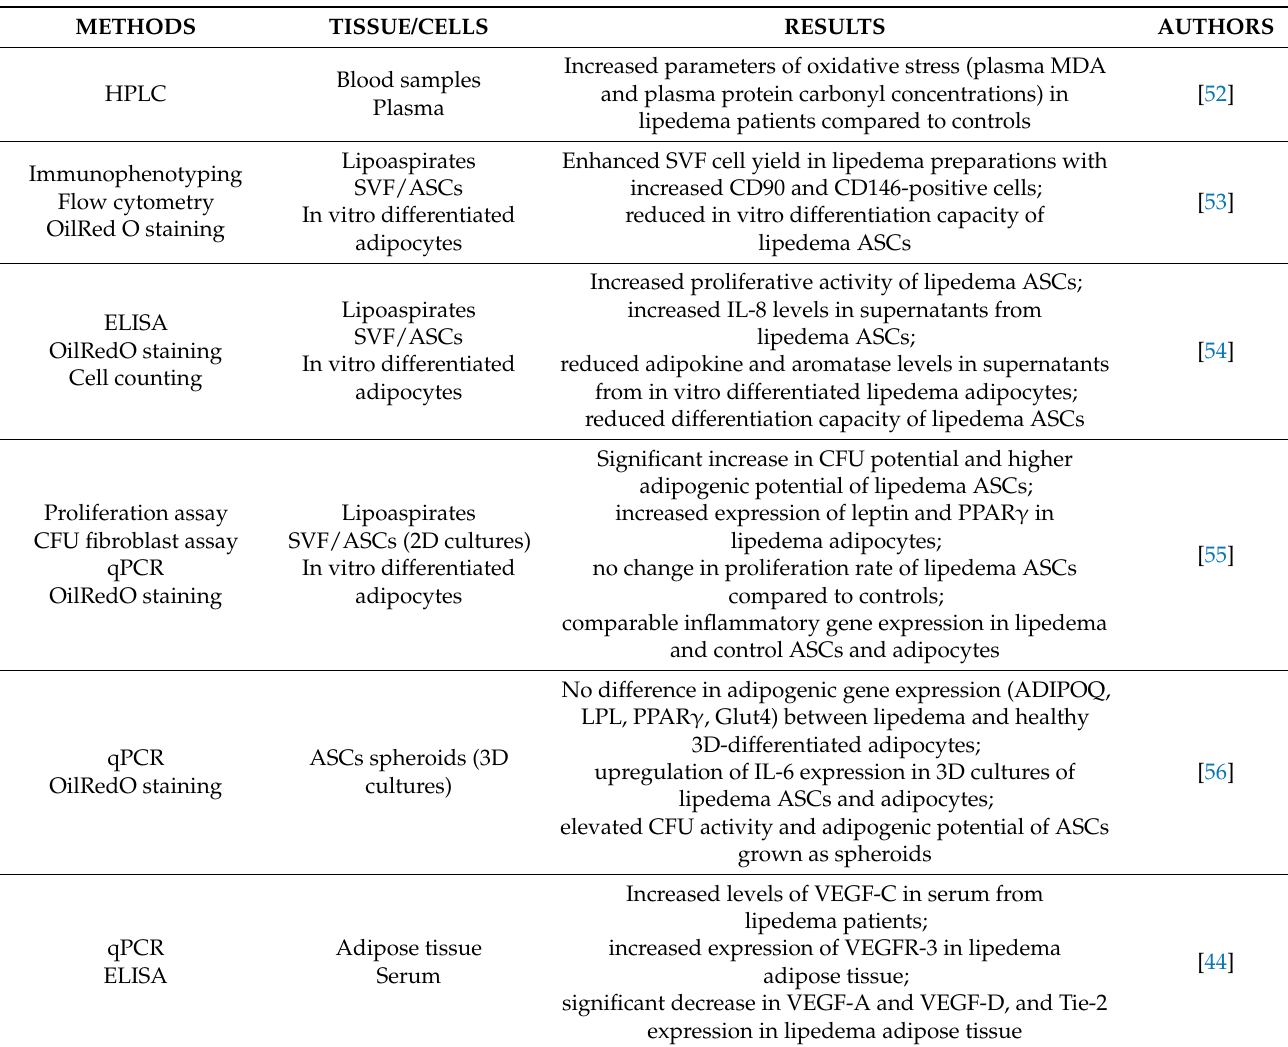
Table 2. Molecular studies and cell-based functional